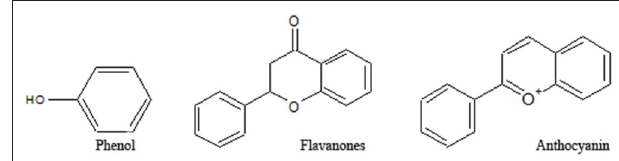
FIGURE 3 | Structures of various groups of phenolic compounds (Hussain, 2016; Mandal et al., 2017; Xi et al.,